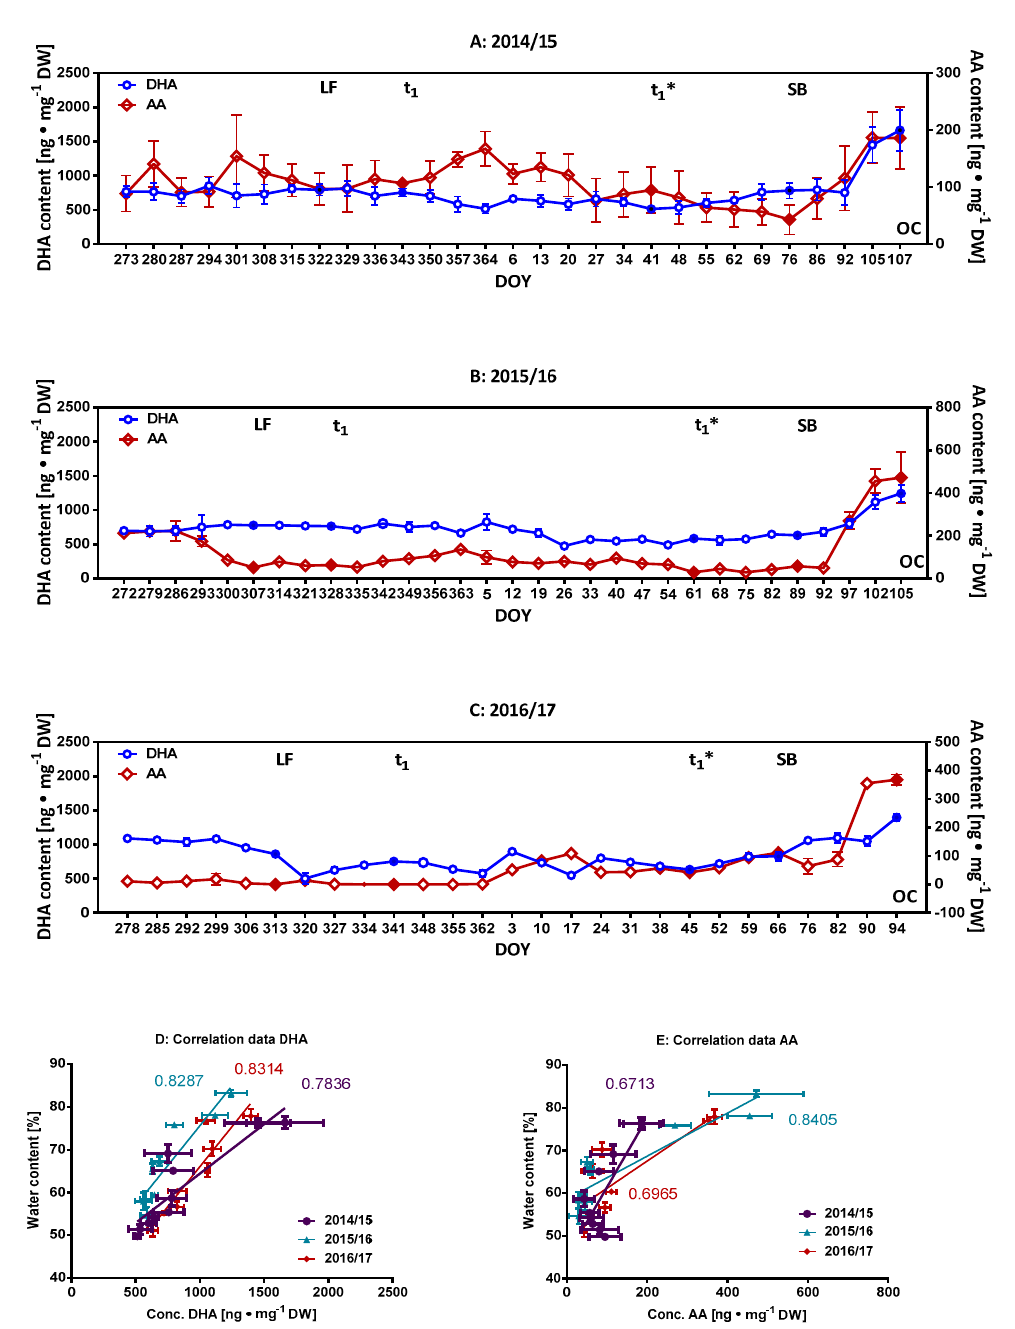
Figure 4. Weekly and development orientated changes of the content of AA and DHA content. ( A ) Season 2014/15; ( B ) Season 2015/16 and ( C ) Season 2016/17. Filled symbols indicate developmental milestones; ( D ) Correlation of water content v/s DHA values; ( E ) Correlation of water content v/s AA values; both for the buds of the phenophase t 1 *–OC. Abbreviations: AA, ascorbic acid; DHA, dehydroascorbic acid; LF, leaf fall; t 1 = endodormancy release, t 1 * = beginning of ontogenetic development, SB = swollen bud, SG = side green, GT = green tip, TC = tight cluster, OC = open cluster, DOY, day of year; DW, dry weight.